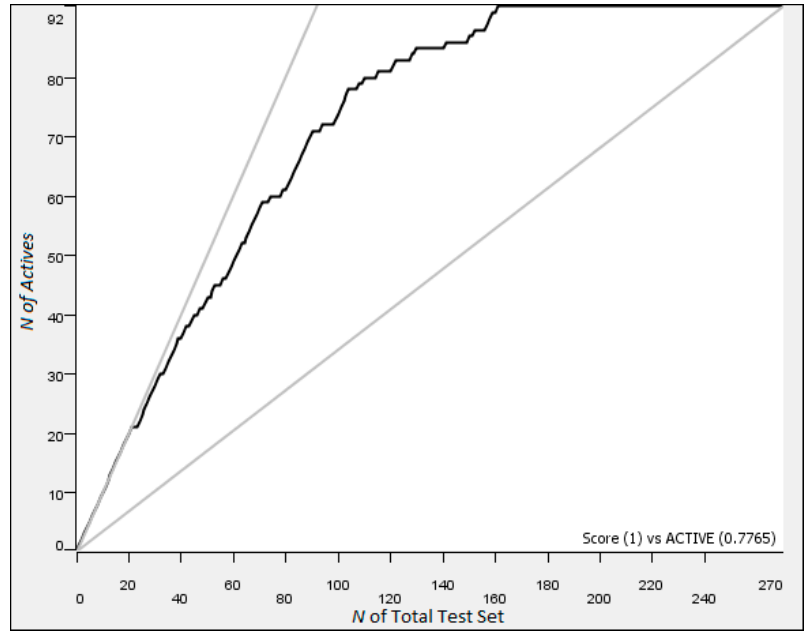
Figure 5. Enrichment plot for the NBN Trained on the ALK dataset with a <20 nM classification.